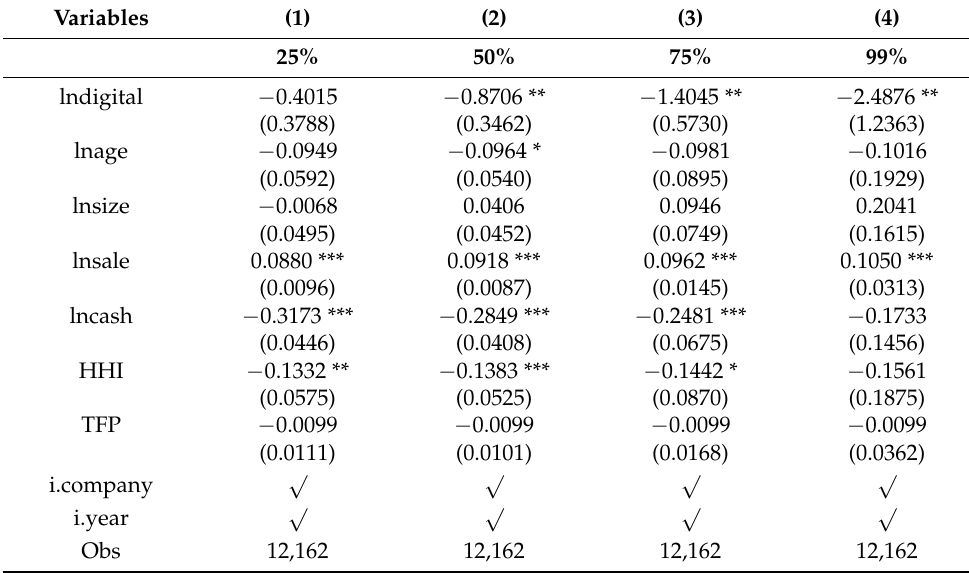
Table 7. Quantile test of carbon emission